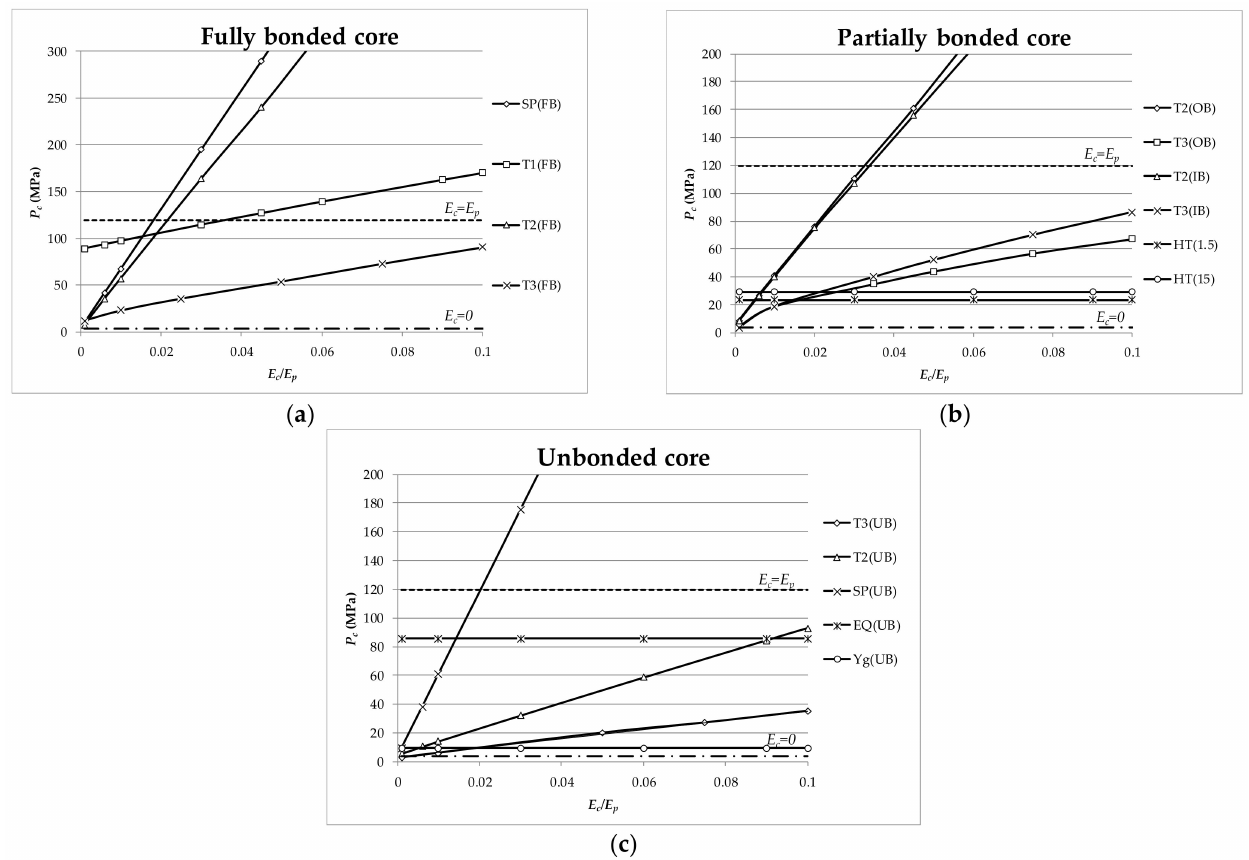
Figure 7. Variation of P c with E c / E p ( a ) Fully bonded, ( b ) Partially bonded, and ( c ) Unbonded